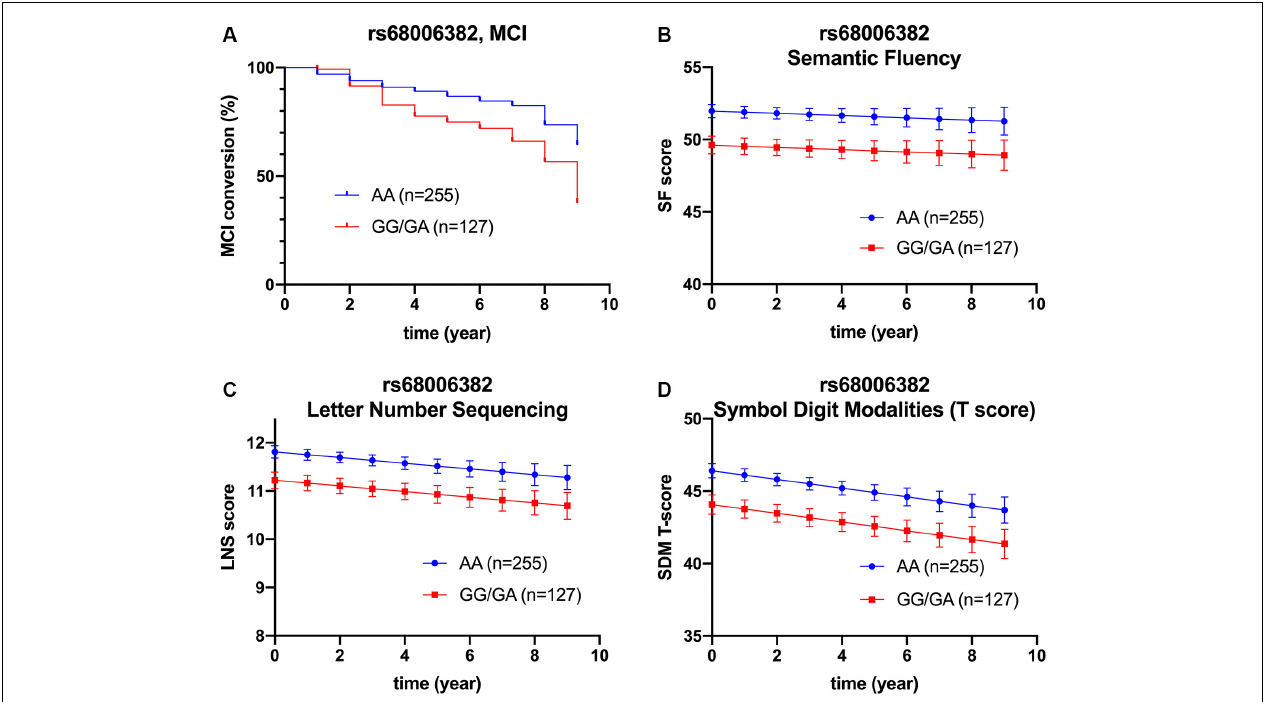
FIGURE 2 | Association between rs68006382 and cognition. rs68006382 (GG/GA vs. AA) had faster conversion to MCI (HR = 1.973, 95% CI = 1.246–3.123, p = 0.004) (A) . rs68006382 GG/GA genotype also had worse performance in semantic fluency test ( β = − 2.357, SE = 0.691, p = 0.001) (B) , letter-number sequencing ( β = − 0.587, SE = 0.193, p = 0.003) (C) , and symbol digit modalities test ( β = − 2.339, SE = 0.193, p = 0.002) (D) . Covariates for cox regression and linear mixed model included age, sex, APOE ε 4 carriage, years of education, and baseline MoCA score. Lines in Panels (B–D) represent the estimated marginal mean from the mixed model. MCI, mild cognitive